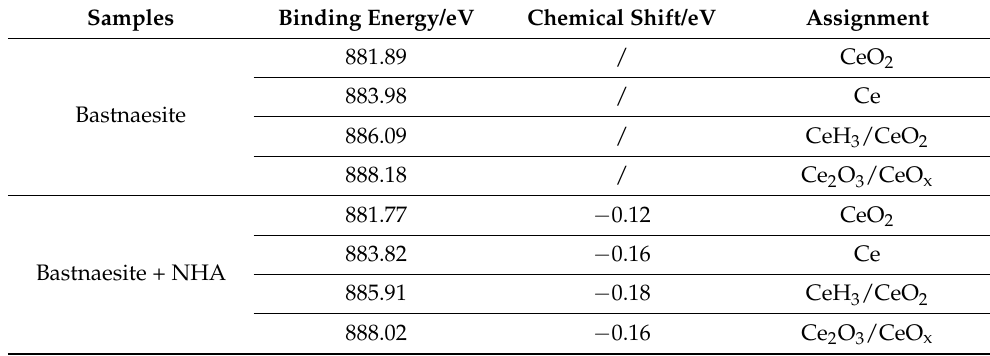
Table 7. Analysis results of Ce 3d5/2 XPS spectra of bastnaesite samples untreated and treated with